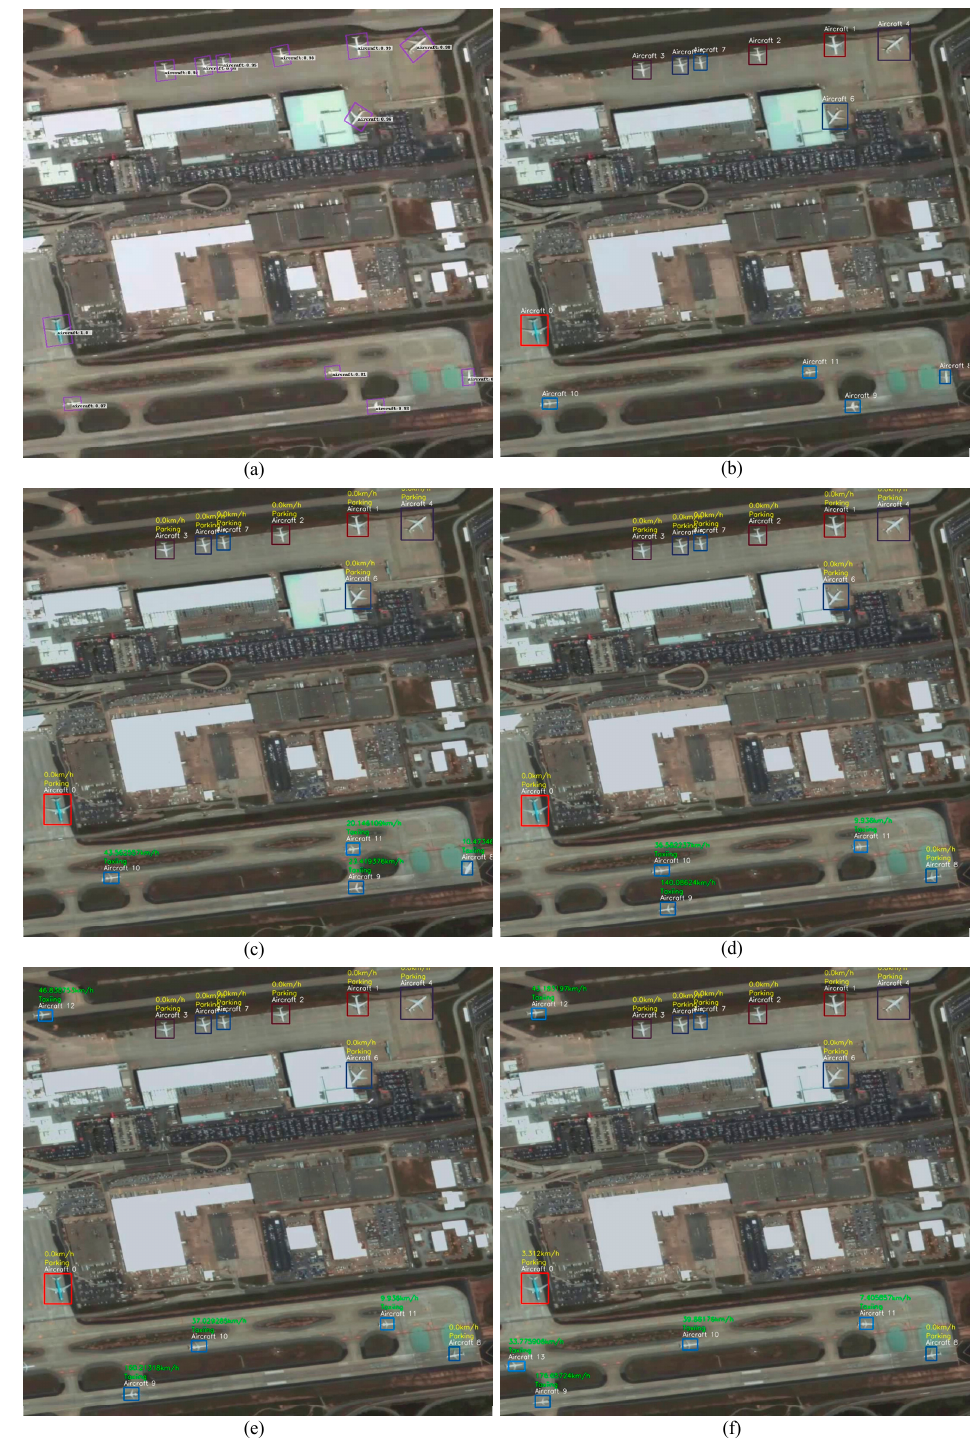
Figure 11. Screenshots of the experimental results from test Video 2. (a) Aircraft detection results in the first frame of the video; (b) Aircrafts detected in the starting frame are all tracked stably; (c) The speed of each tracked aircraft is measured and from this the type of aircraft activity is determined; (d) The aircraft is stable tracked even with complex environmental backgrounds, lighting conditions, and various movements of the aircraft, such as turning (Aircraft 8); (e) A newly entering aircraft (Aircraft 12) is also identified and stably tracked; (f) Another entering aircraft (Aircraft 13) is identified and stably tracked.